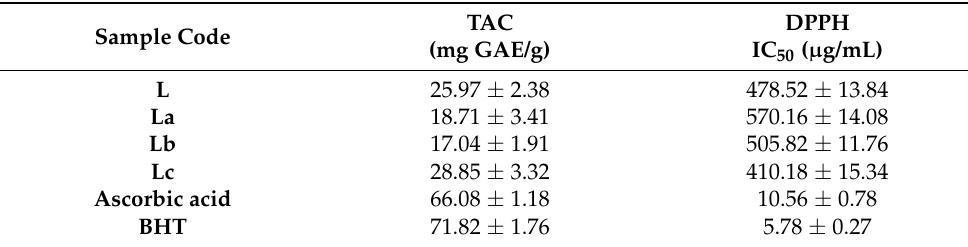
Table 3. Total antioxidant activity and DPPH radical scavenging activity of the Schiff base compound and its